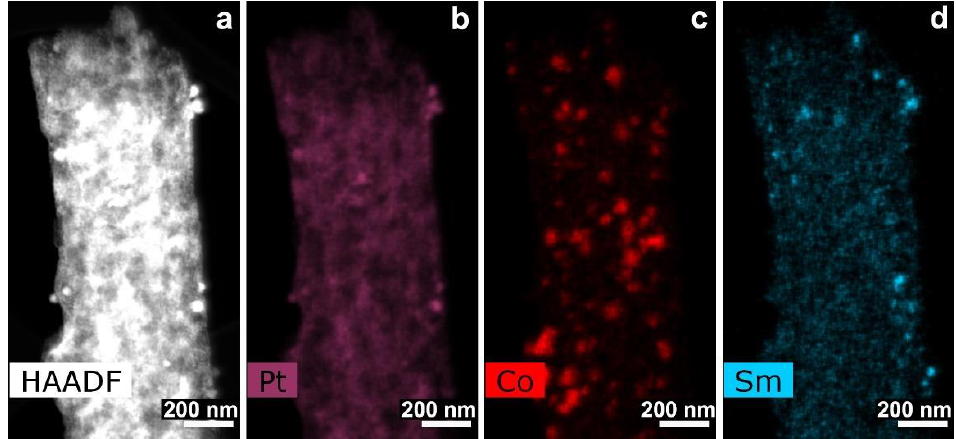
Figure 15. ( a ) HAADF STEM image and EDX distribution maps for ( b ) Pt, ( c ) Co and ( d ) Sm for sample Figure 15. (a) HAADF STEM image and EDX distribution maps for (b) Pt, (c) Co and (d) Sm for sample Pt / Pt/3.